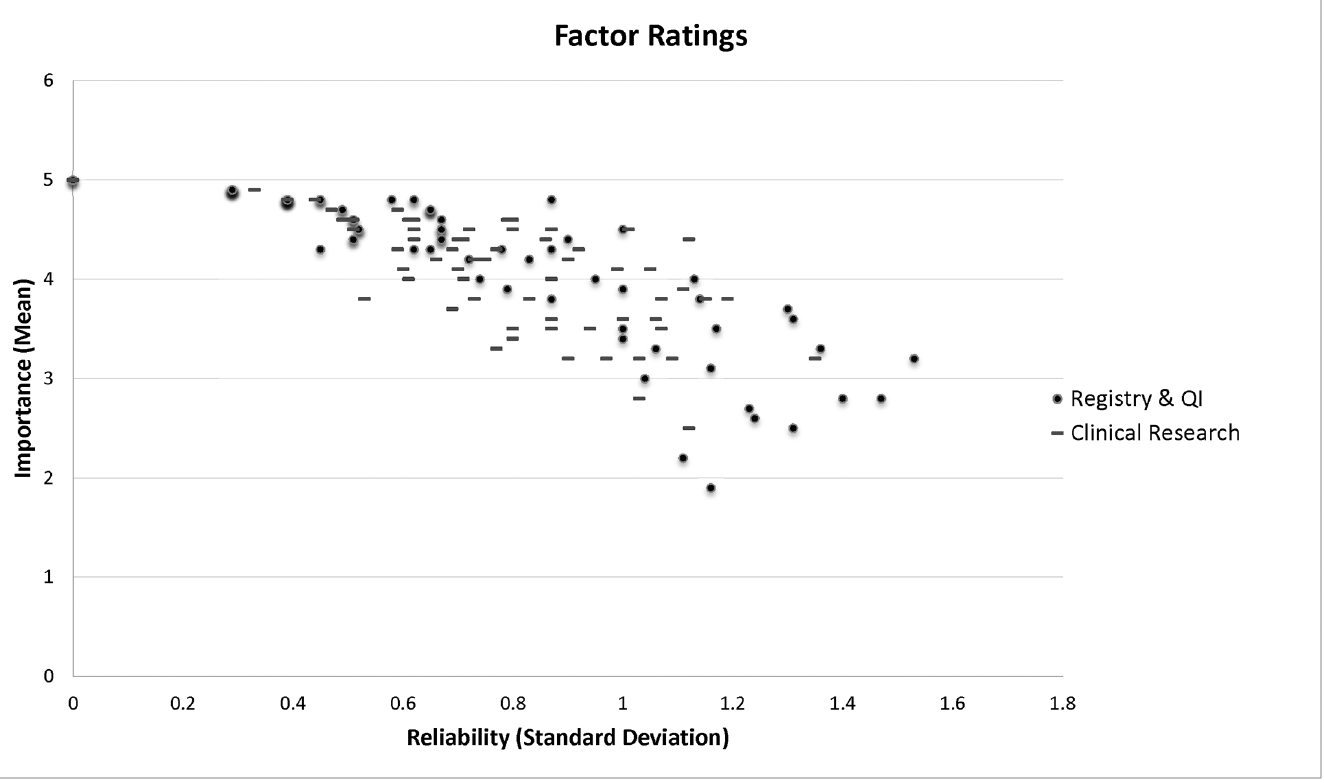
Fig 4. Importance versus reliability of